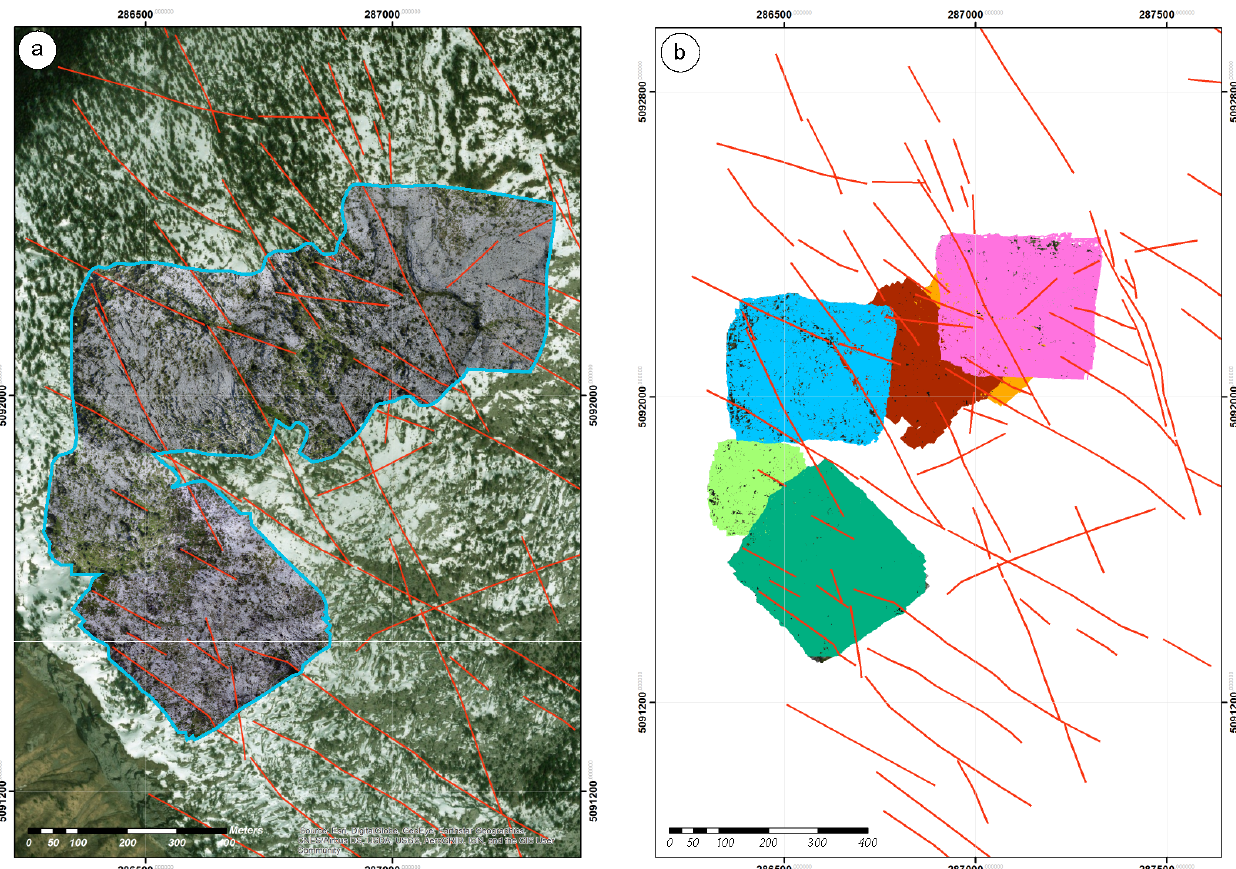
Figure 7. Drone photogrammetry coverage area from the Parmelan (a) Region within the Parmelan plateau highlighting the areal extent of the drone photogrammetric orthomosaics which are projected over the base map. Manually traced large-scale faults are depicted in red. This map was generated using satellite imagery obtained from ESRI World Imagery (https://services.arcgisonline.com/ArcGIS/rest/services/ World_Imagery/MapServer, last access: 12 February 2019) and modified using ArcGIS 10.3 and ArcMap 10.3 software by ESRI (http: //www.esri.com/, last access: 12 February 2019). Service layer credits: ESRI, DigitalGlobe, GeoEye, Earthstar Geographics, CNES/Airbus DS, USDA, USGS, AeroGRID, IGN, and the GIS User Community. (b) Spatial extent of the drone coverage of each of the six UAV flight missions in different